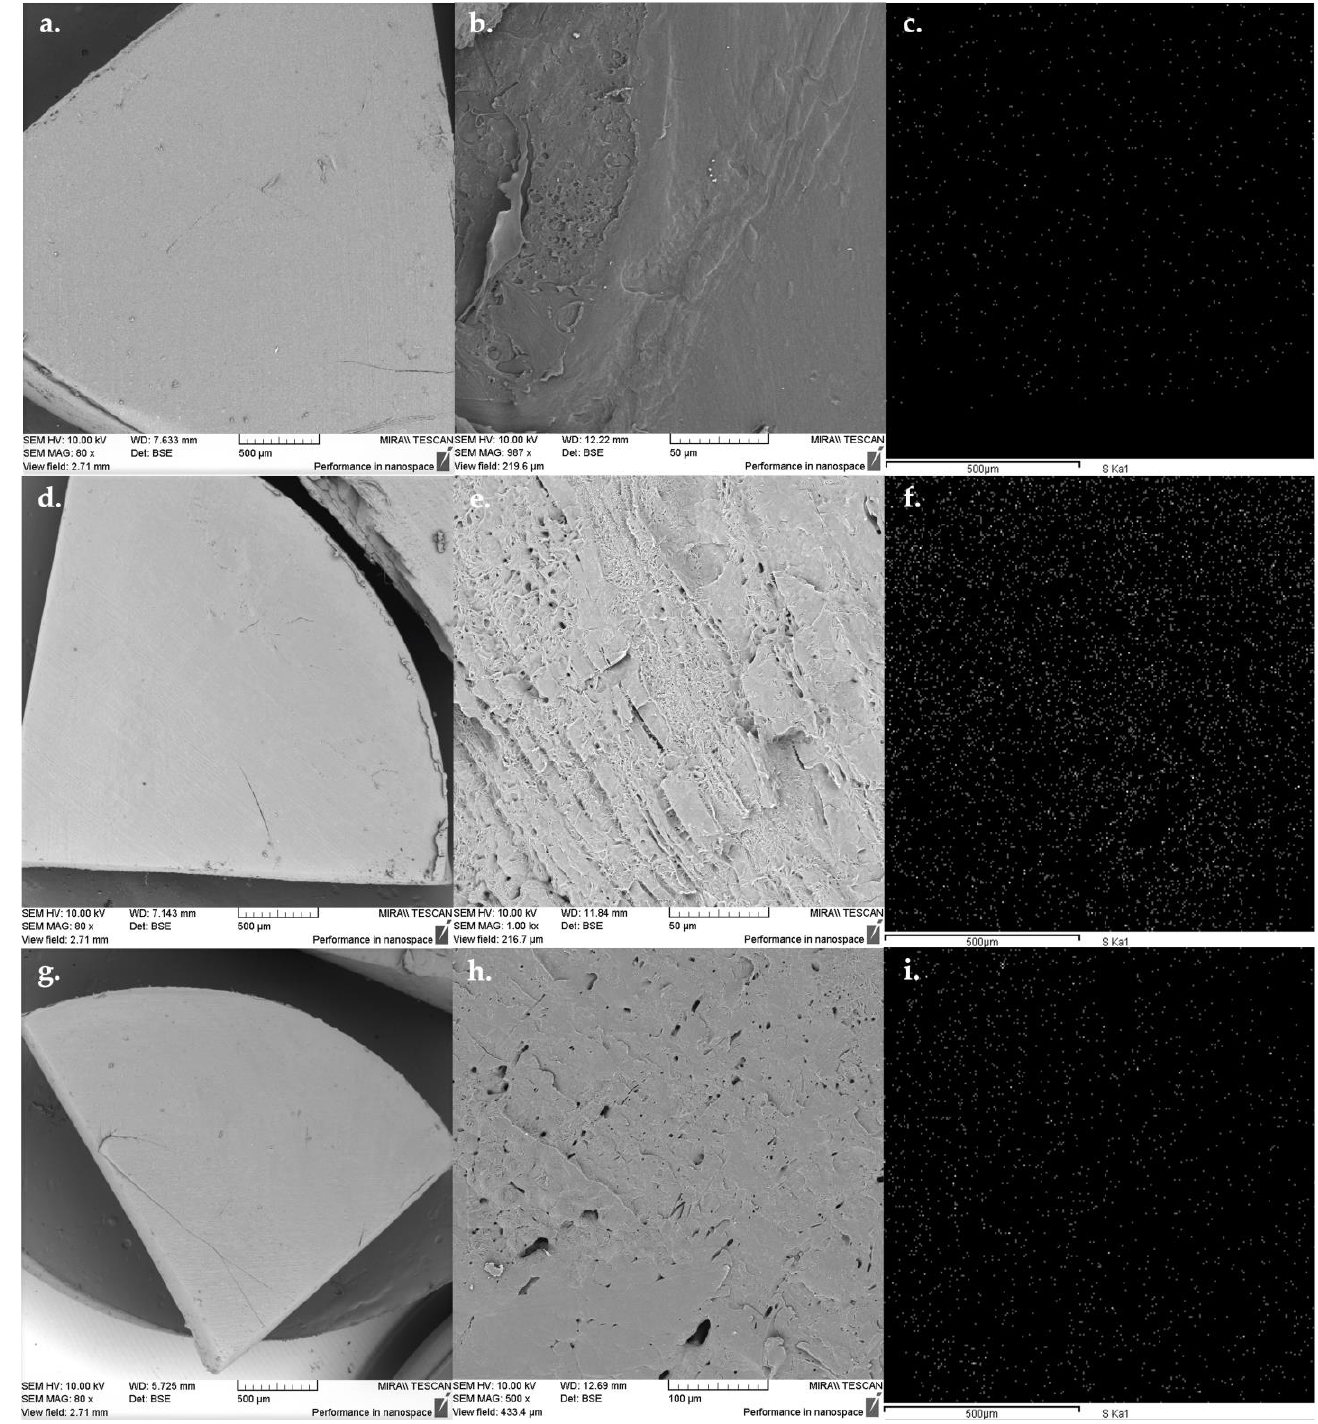
Figure 7. SDF 1 ( a , b ), SDF 2 ( d , e ), and SDF 3 ( g , h ) images of the external and internal surfaces